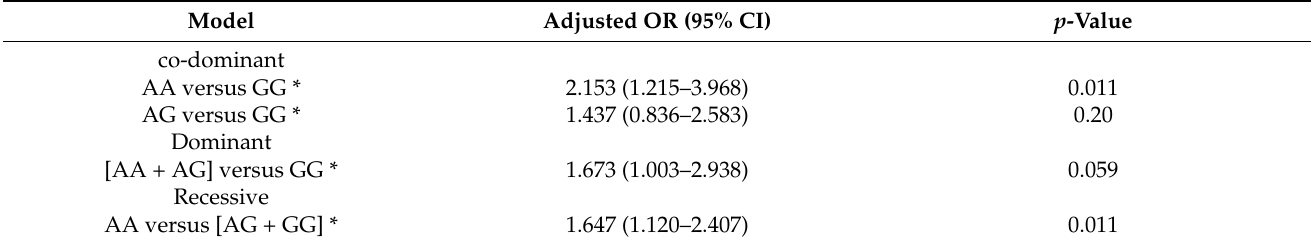
Table 3. Logistic regression model to explain the MI risk for the rs3825807 polymorphism of